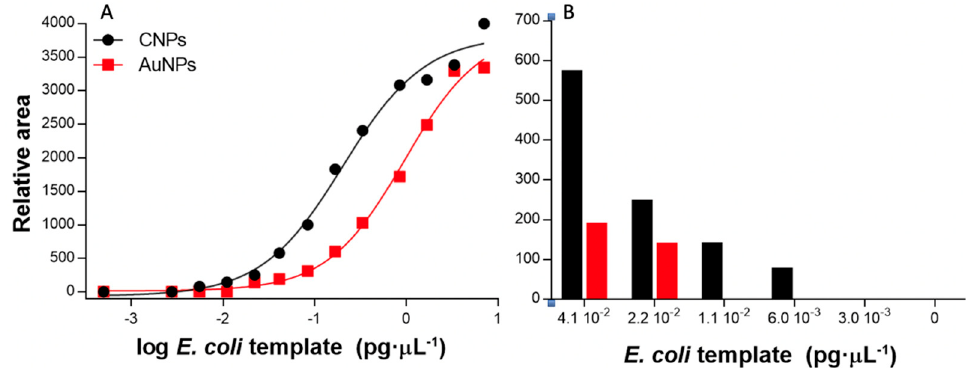
Figure 6. ( A ) The results obtained for the LFA at template concentrations ranging from 0.00 to 7.09